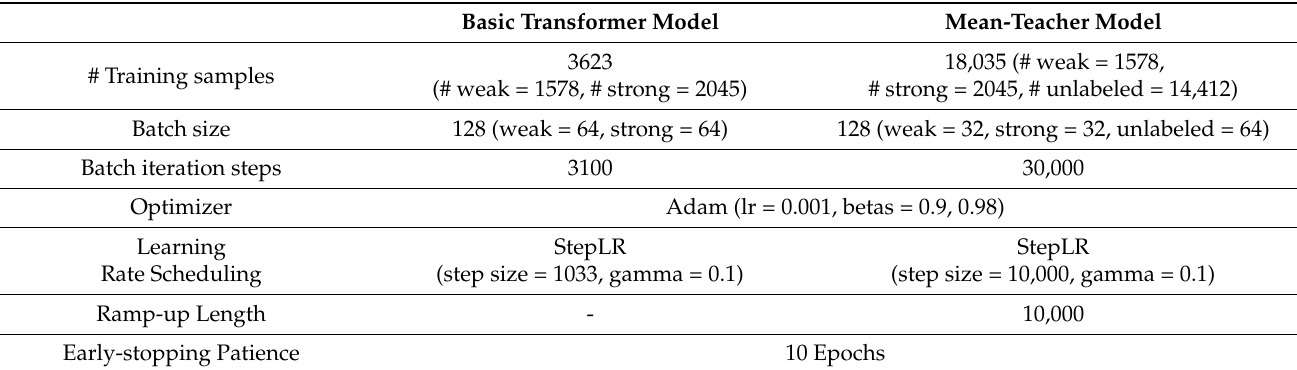
Table 2. Network training